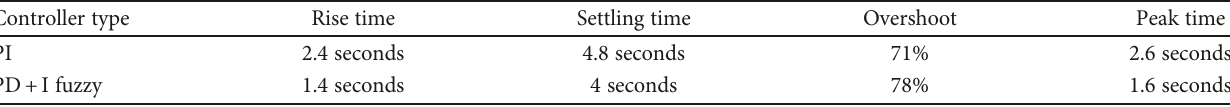
Figure 15: (a) Behavior of the voltage of the battery bank in discharge mode and (b) behavior of the current of the battery bank in discharge mode. Table 2: Response parameters of the current extracted from the battery bank.